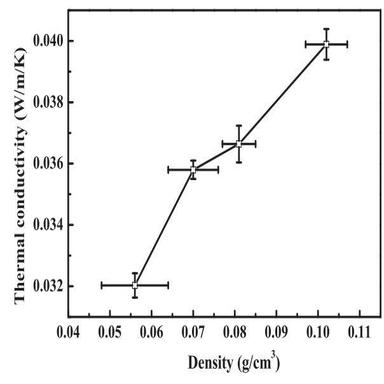
The thermal conductivities of the PFMs at different densities.